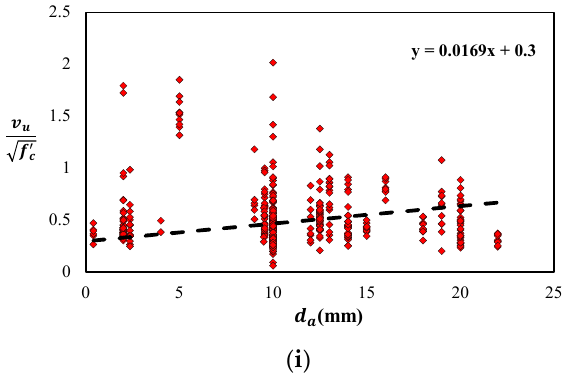
Figure 1. Factors influencing the shear strength of steel fiber reinforced (steel fiber reinforced concrete (SFRC)) concrete beam: ( a ) Concrete compressive strength, ( b ) Reinforcement ratio, ( c ) Effective depth, ( d ) Span to depth ratio, ( e ) Fiber volume fraction, ( f ) Fiber factor, ( g ) Fiber diameter, ( h ) Tensile strength of fiber, ( i ) Diameter of aggregate.